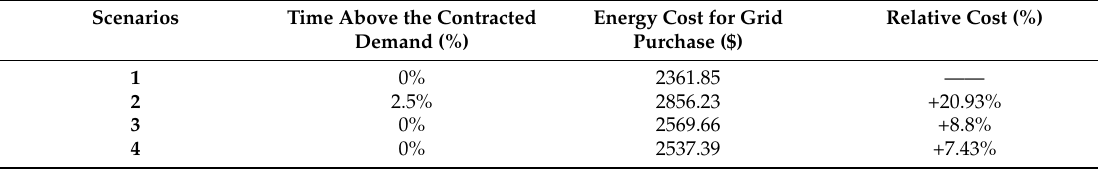
Table 2. Comparison for the operation of the parking lot with different EMS